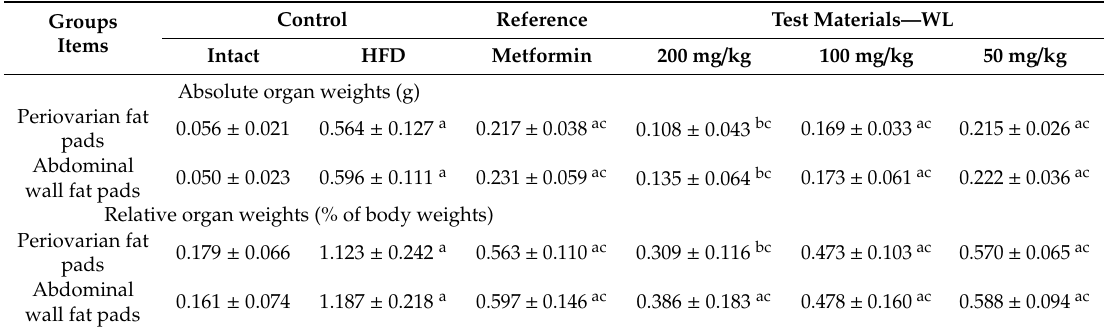
Table 2. Variations on absolute and relative fat pads weights in NFD or HFD supplied mice.